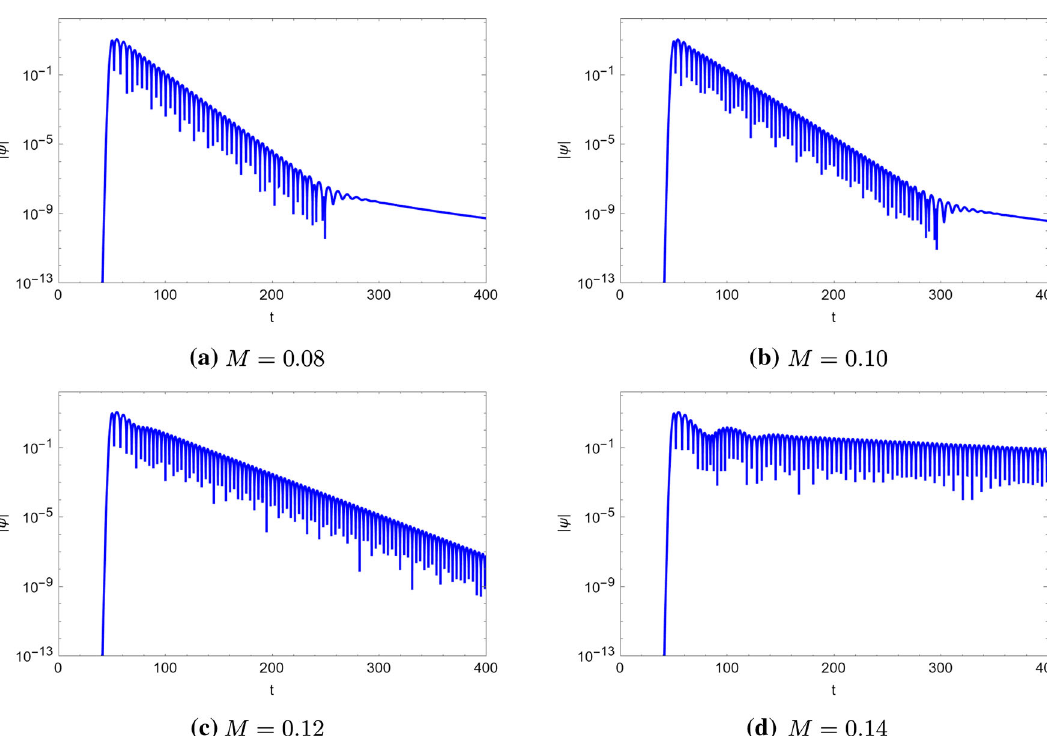
Fig. 9 The time evolution profiles with different M . We set l = 2 , Q e = − 10 ,γ 1 = − 10 ,γ 2 =